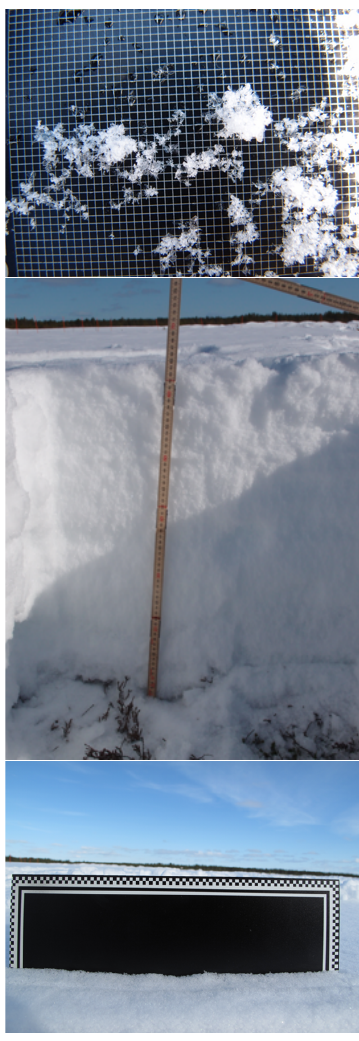
Figure 4. More snow profiles taken on the 3 April of unprocessed snow near the FIGIFIGO spot. Because of near-zero temperature, the snow crystals melt fast on the black plate, and the smallest de- tails and grains have already disappeared.